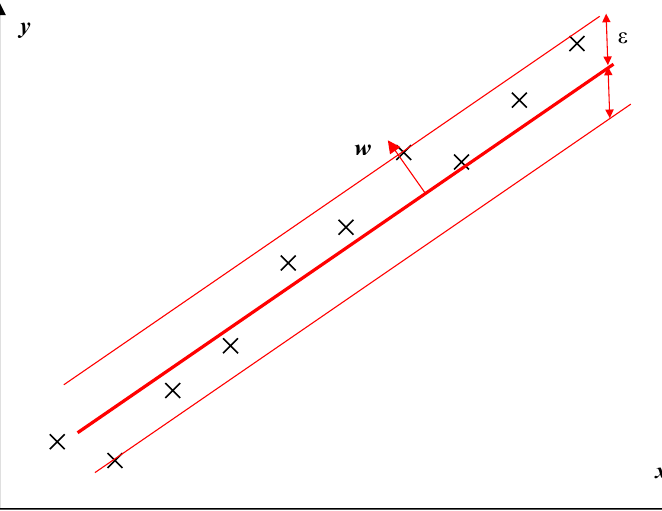
Figure 2. Schematic of support vector regression method.